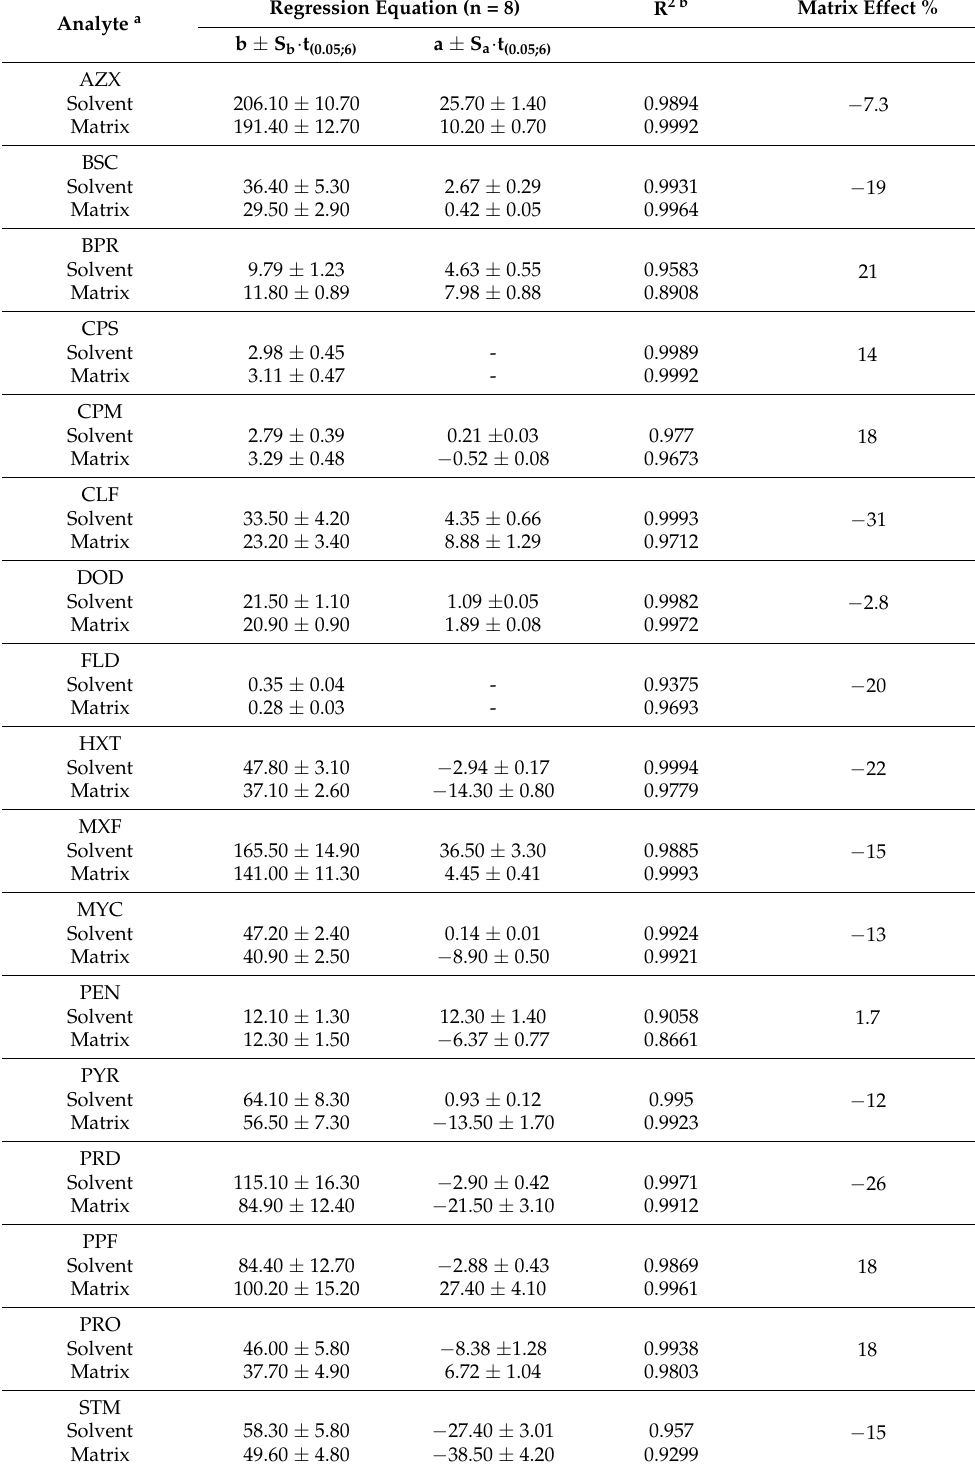
Table 1. Calibration data for the analyte curves in solvent (ethanol), for the analyte curves in matrix by spiking post-extraction, and evaluation of the matrix effect